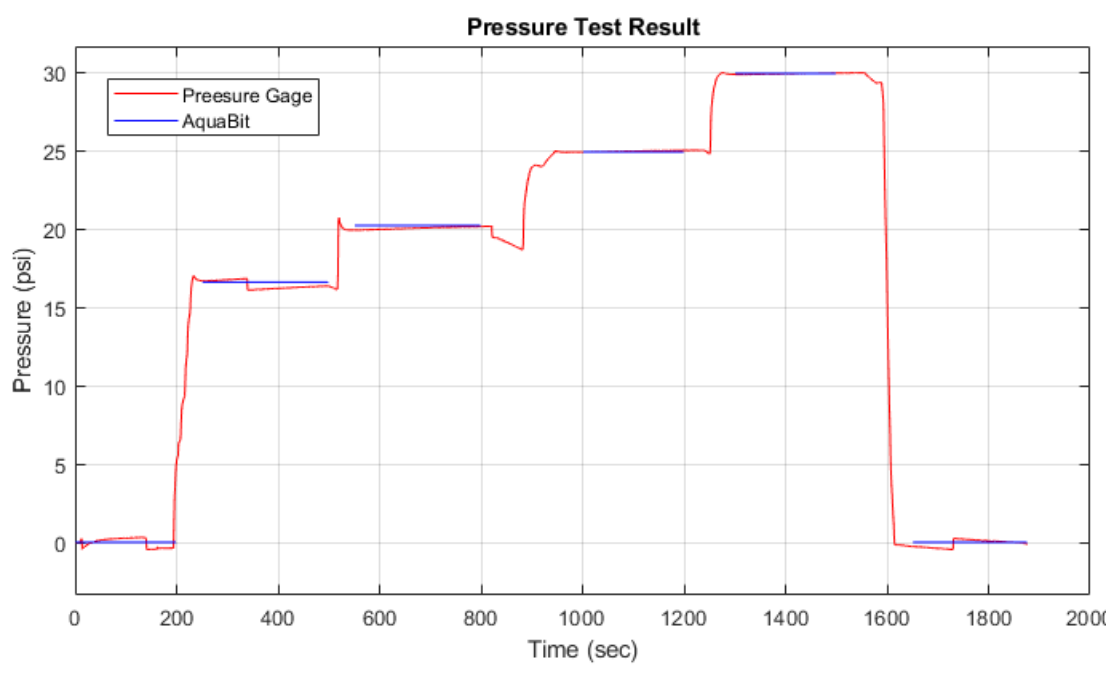
Figure 13. Pressure sensor test in air result.